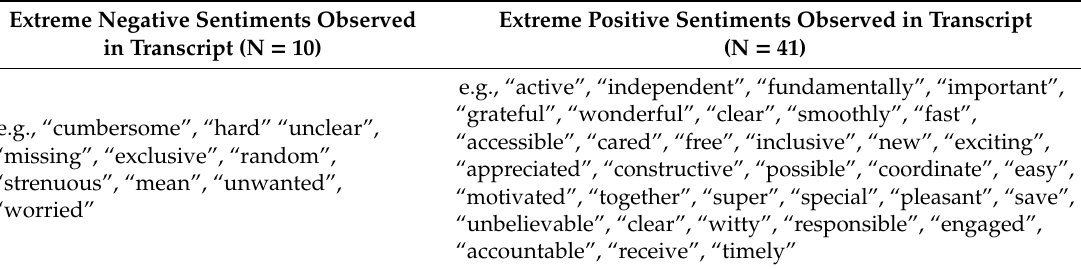
Table 7. General sentiment recorded for the discussion